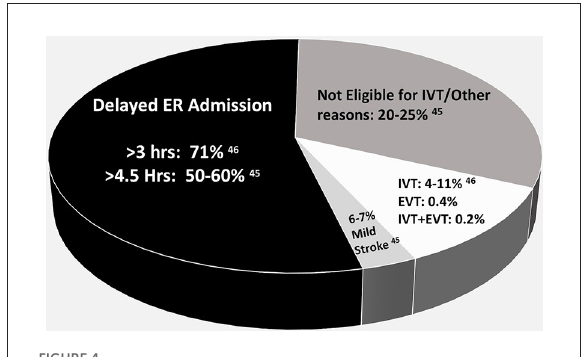
FIGURE4 Patients thrombolyzed and not thrombolyzed among all acute ischemic